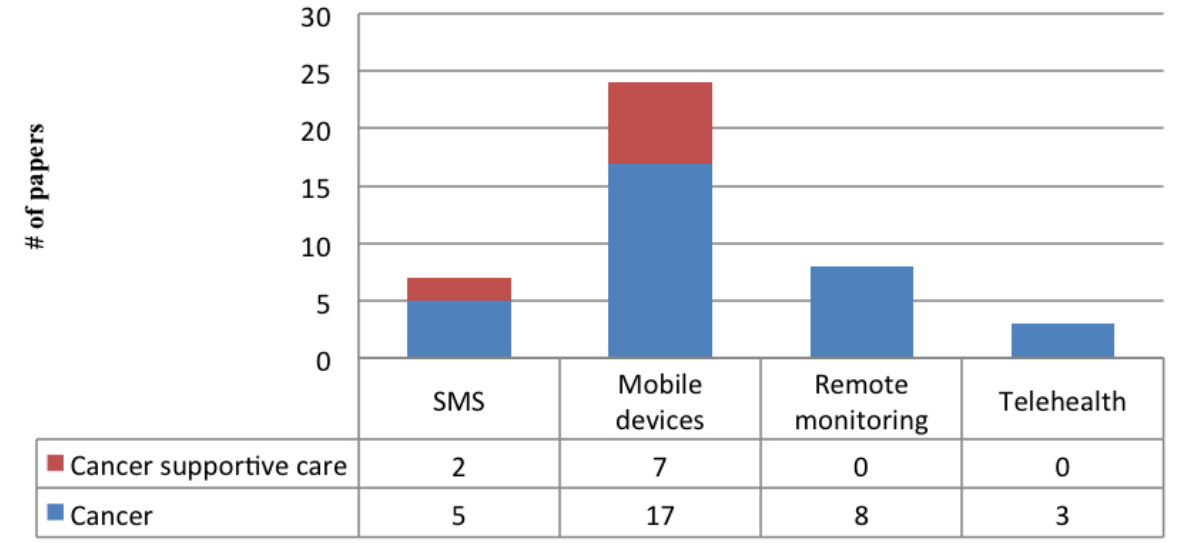
Figure 11. Mobile technologies in the phase of health care processes: focus on cancer